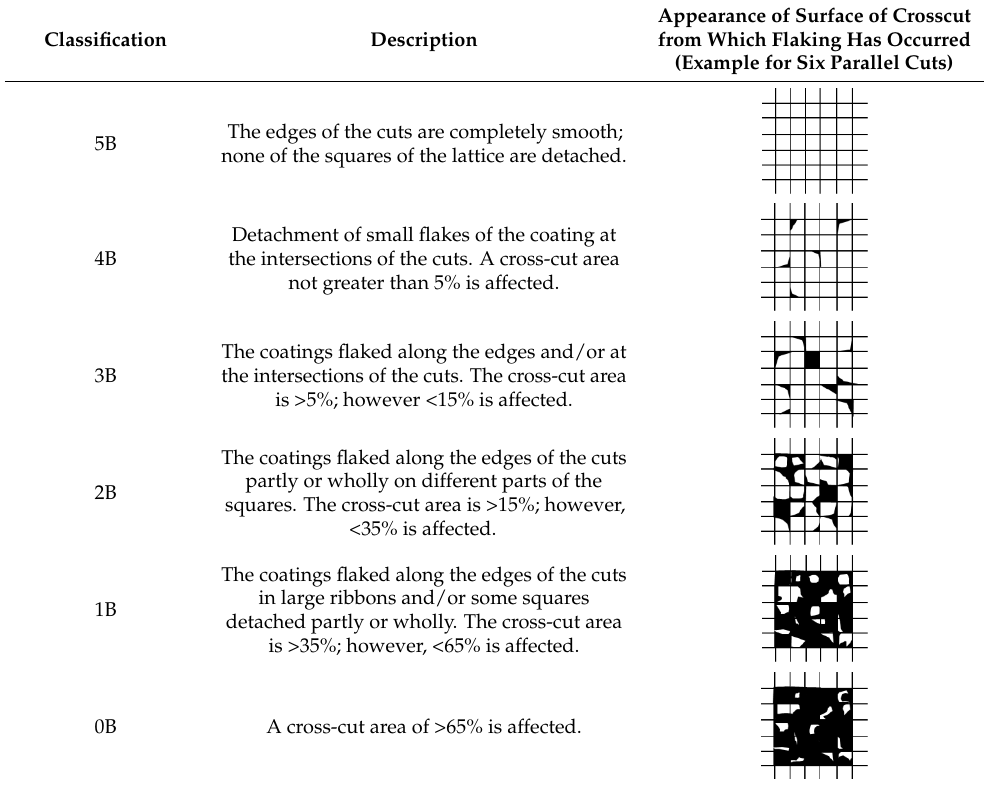
Table 3. Classification of test results.